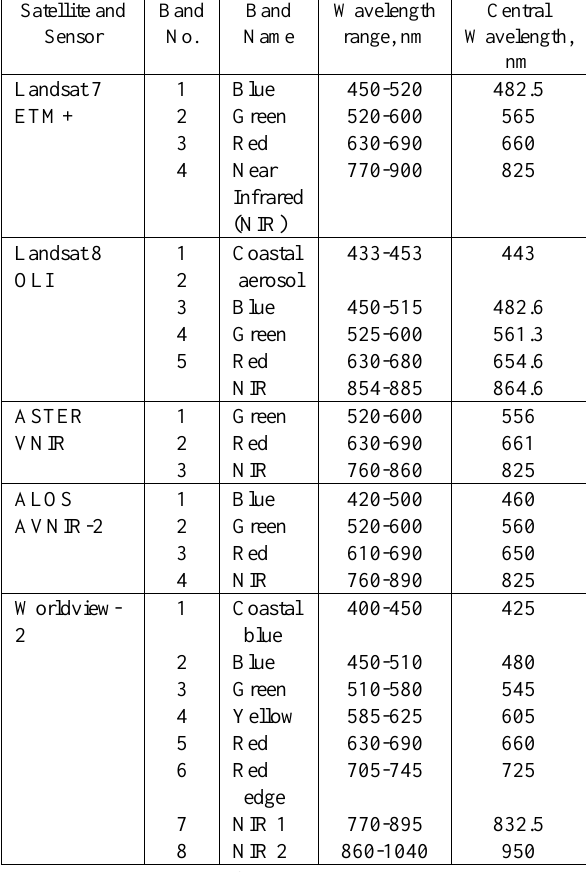
Table 2. Description of band numbers, names, wavelength ranges, and central wavelengths of optical satellite sensors.